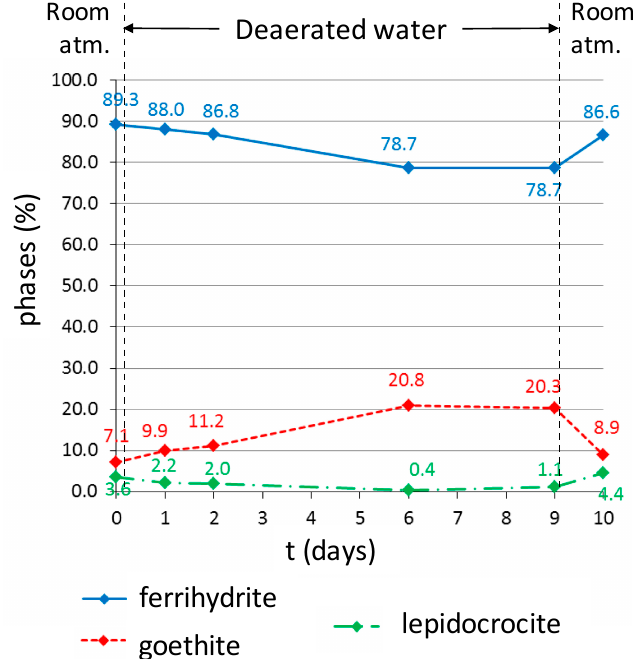
Figure 9. Global average contents (%) of the phases detected in the zone marked with a black rectangle on Figure 2b, calculated from the maps presented in Figure 7.